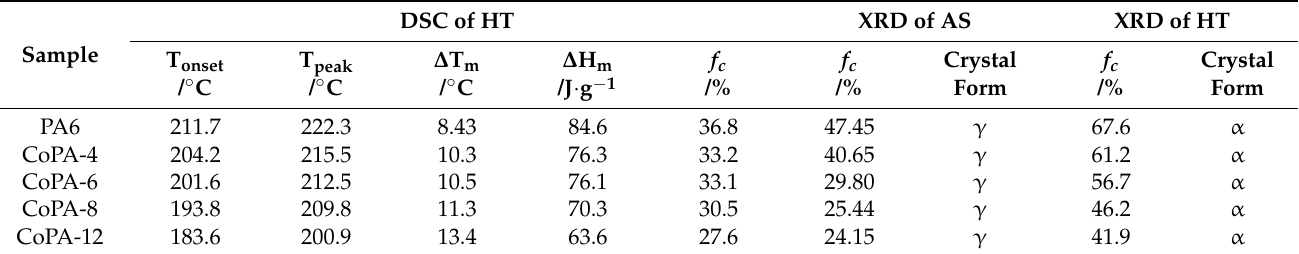
Table 1. Melting behavior and crystallization analysis of PA6 and CoPAs fibers. DSC of HT XRD of AS XRD of